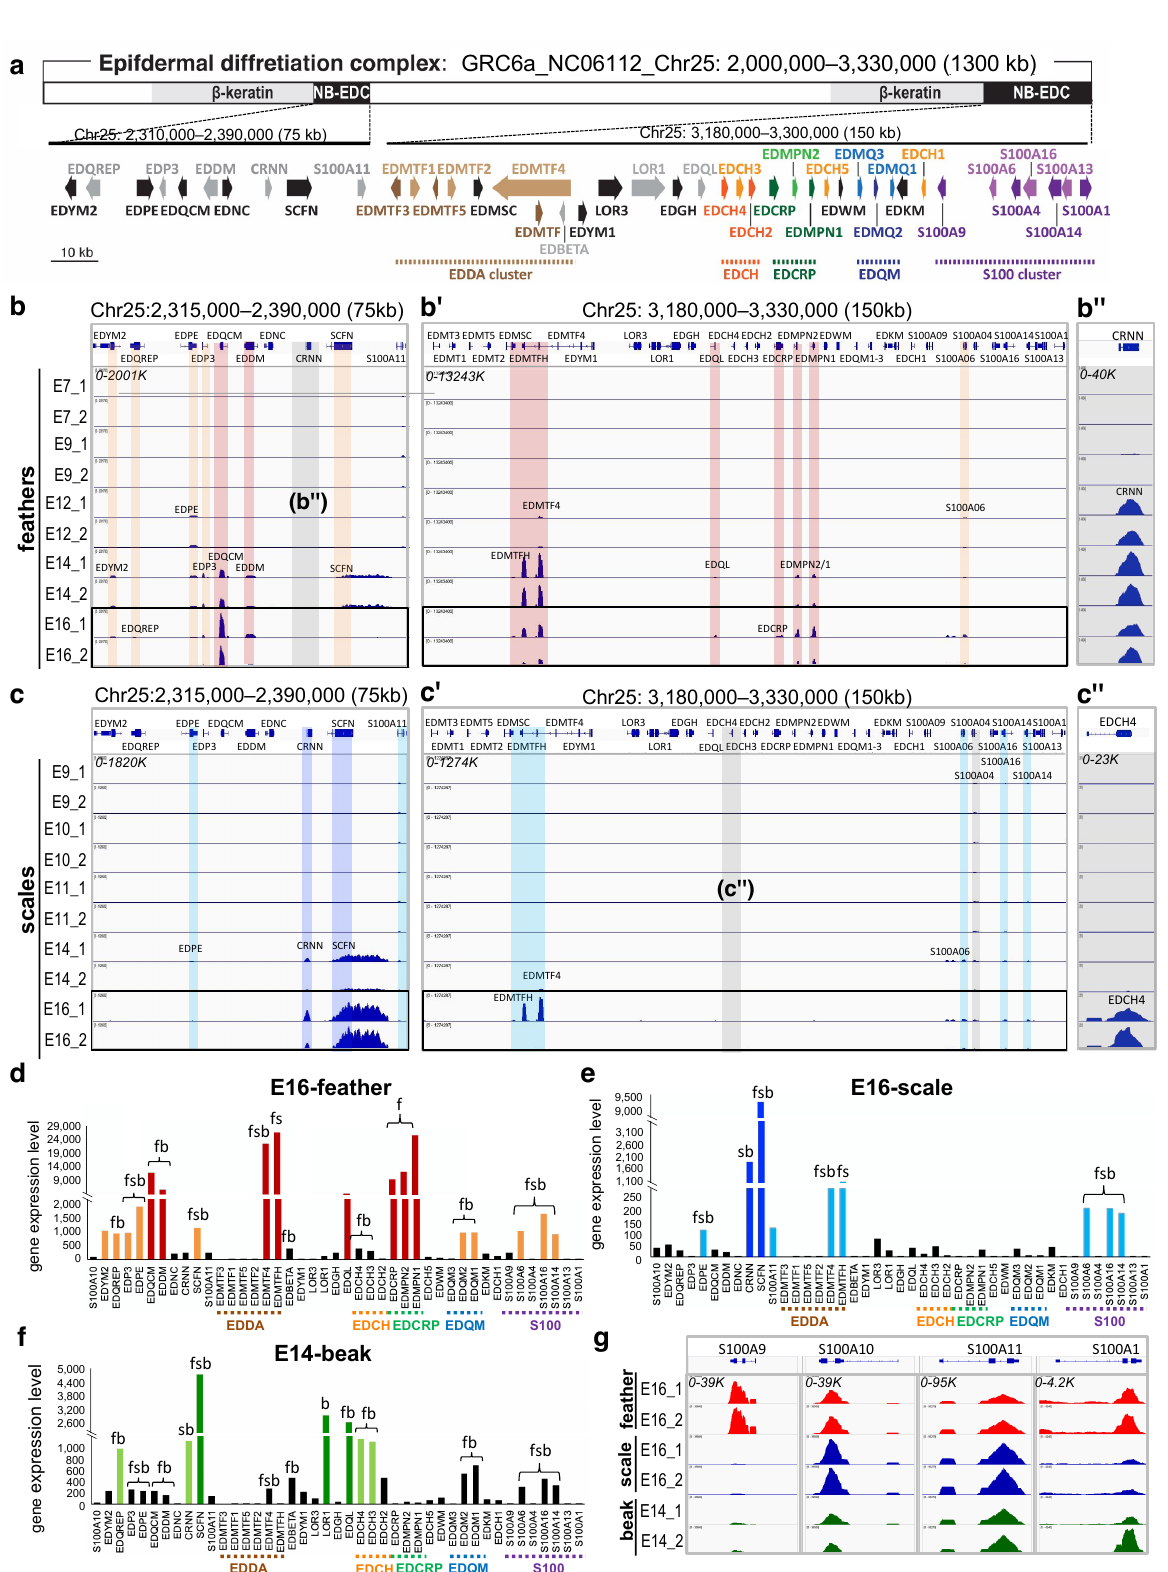
Figure 1. Epidermal differentiation complex (EDC) on Chr25 with different transcriptional profiles of non- β -keratin